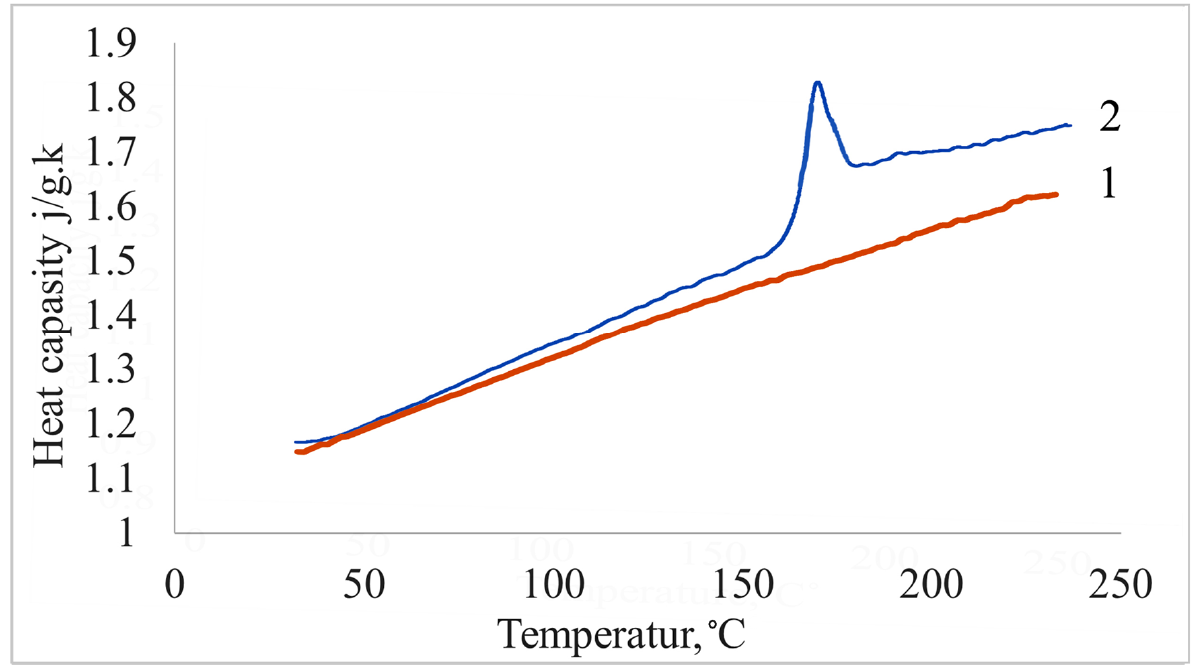
Figure 7. Specific heat capacity versus temperature for Gr (1) and PSU